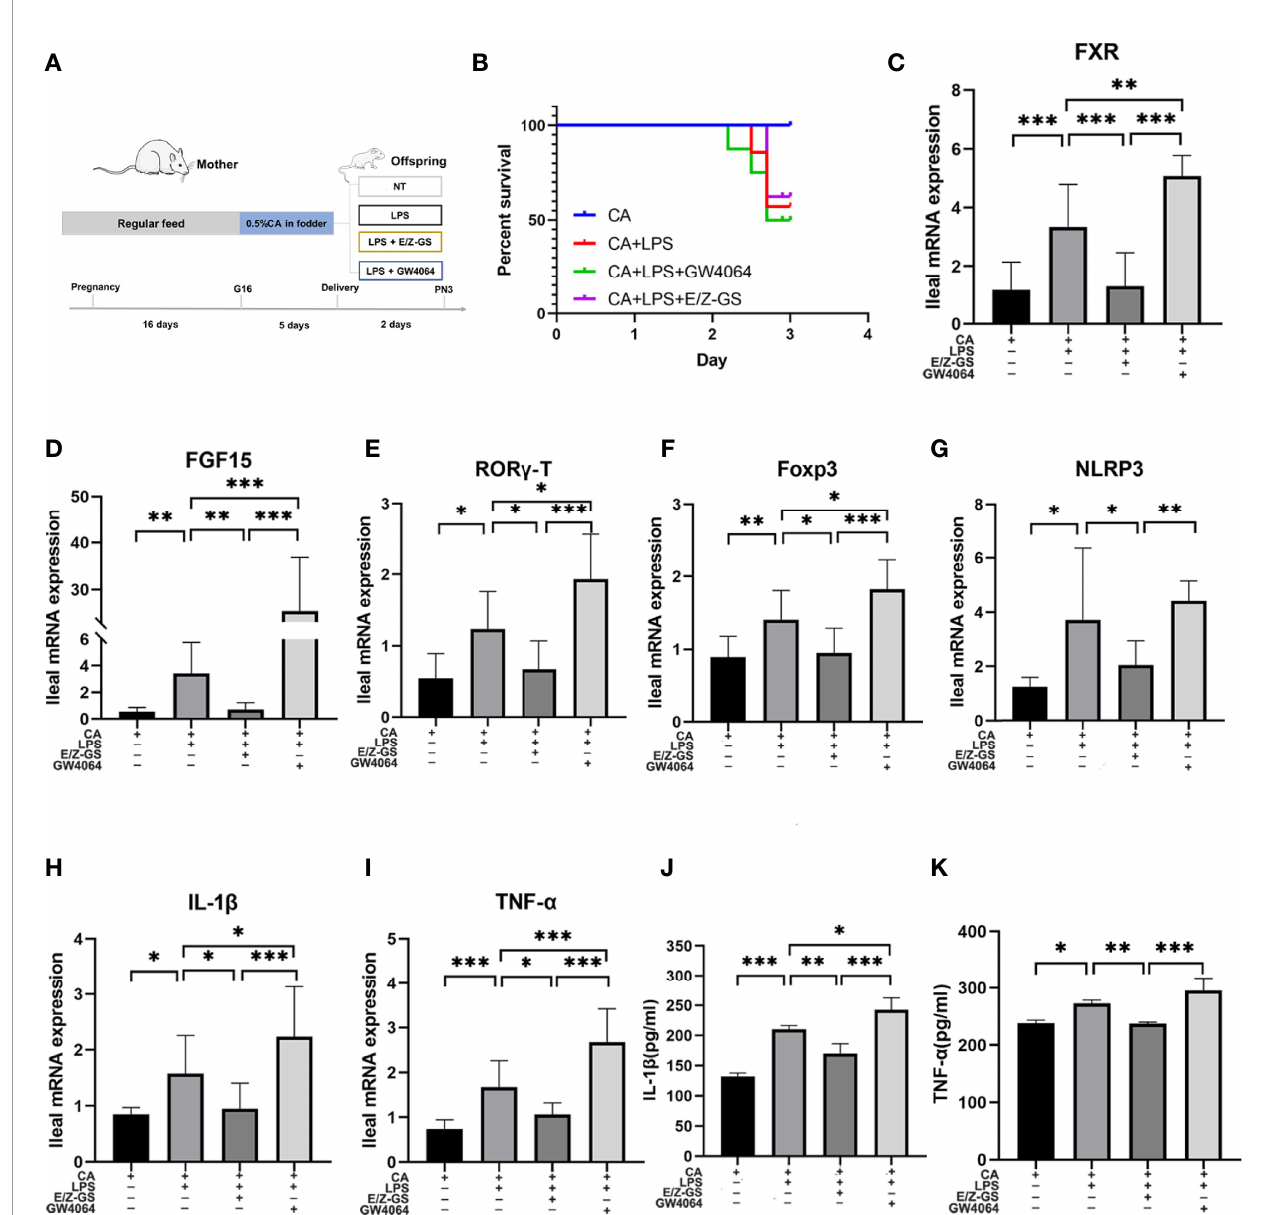
FIGURE 6 | FXR mediates intestinal immune responses to LPS in the offspring from CA-fed mothers. (A) Flow diagram of the experimental procedure. (B) Survival analyses of four groups. (C – I) Ileal mRNA expression of FXR, FGF15, IL-1 b , TNF- a , ROR g -T, Foxp3 and NLRP3. *p < 0.05, **p < 0.01, ***p<0.001. N = 5-7. (J, K) IL-1 b and TNF- a serum levels in four